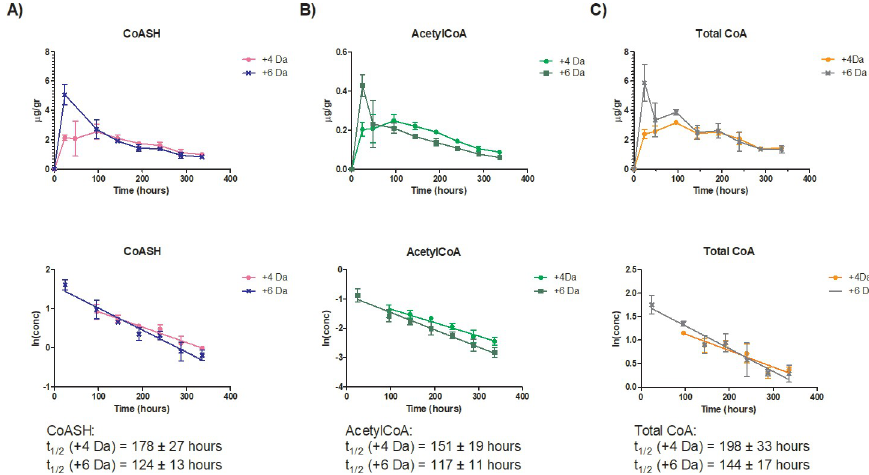
Fig 6. Half-life in male mouse brain of A) free CoA (CoASH) (+4 and+6 AMU), B) acetylCoA (+4 and +6 AMU) and C) total CoA +4 and +6 AMU. C57/Bl6 mice received an intrastriatal injection of 125 μ g of +6 AMU labelled- fosmetpantotenate at each brain hemisphere (250 μ g total dose) and brain samples were collected over a period of 336 h after dosing. For CoASH +4, acetylCoA +4 and total CoA +4 the time interval 96–336 h was considered for the half- life calculation. For CoASH +6, acetylCoA +6 and total CoA +6 the time interval 24–336 h was used and t = 48 h was excluded from the regression. Error bars, mean ± SD for triplicate samples.